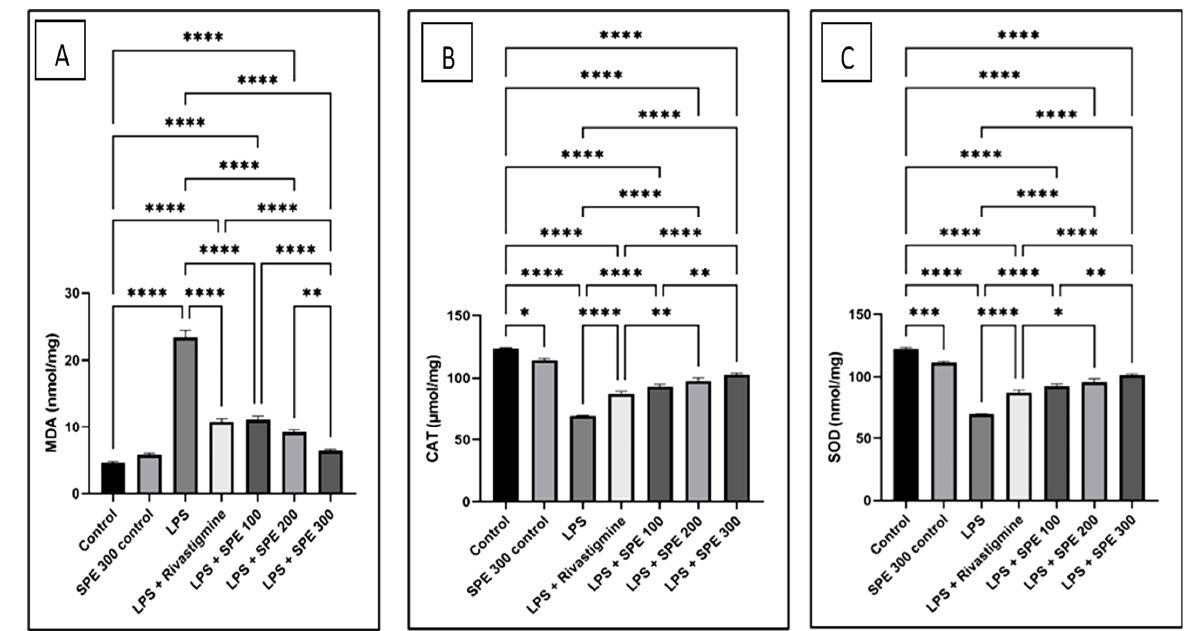
Figure 7. The levels of ( A ) malondialdehyde (MDA), ( B ) catalase (CAT), and ( C ) superoxide dis- mutase (SOD) of the control (group 1), SPE 300 control (group 2), LPS (group 3), LPS + Rivastigmine (group 4), LPS + SPE 100 (group 5), LPS + SPE 200 (group 6), and LPS + SPE 300 (group 7). *: Signif- icant at p ≤ 0.05. **: Significant at p ≤ 0.01. ***: Significant at p ≤ 0.001. ****: Significant at p ≤ 0.0001.